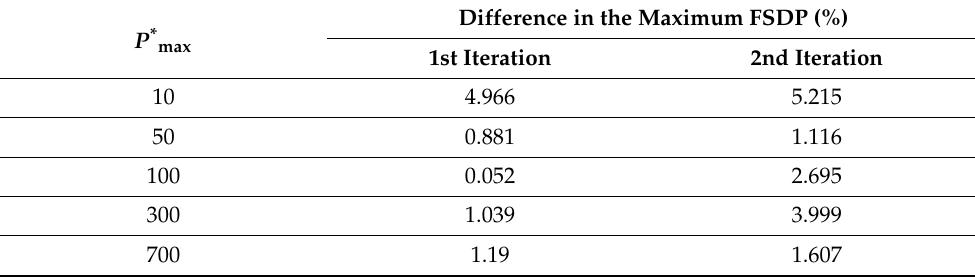
Table A3. The difference between the maximum FSDP obtained from the meshes of iteratively decreasing mesh size and the original